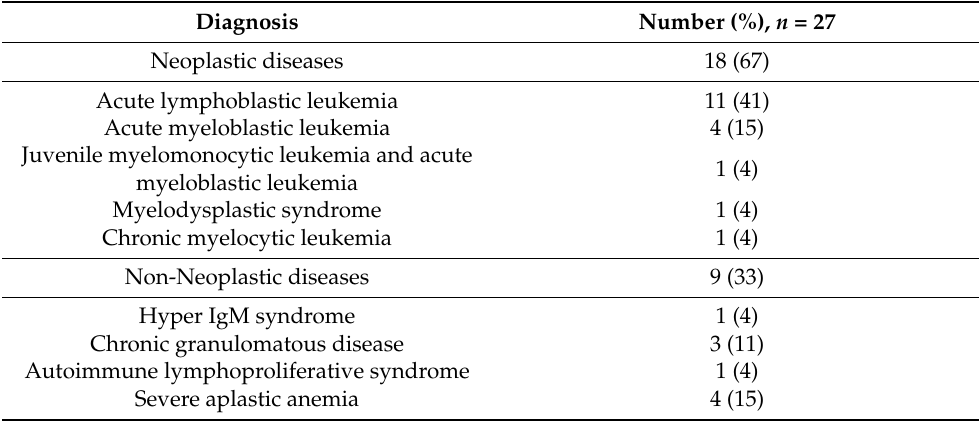
Table 1. The indications for HSCT.